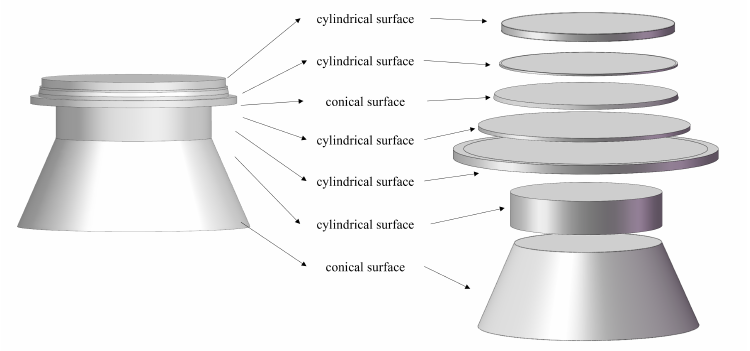
Figure 9. The feature splitting constraints determined by the topological relationship of the CAD model.